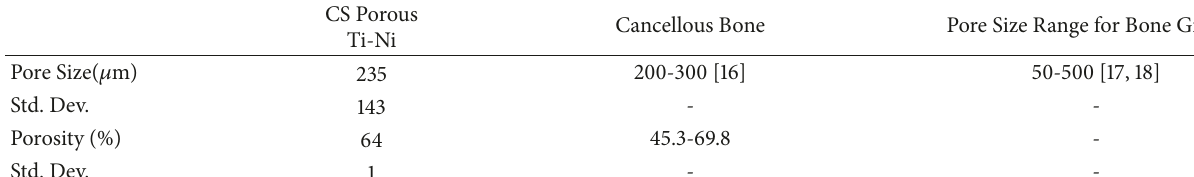
Table 1: Average pore size and porosity of CS Ti-Ni within the range of cancellous bone.